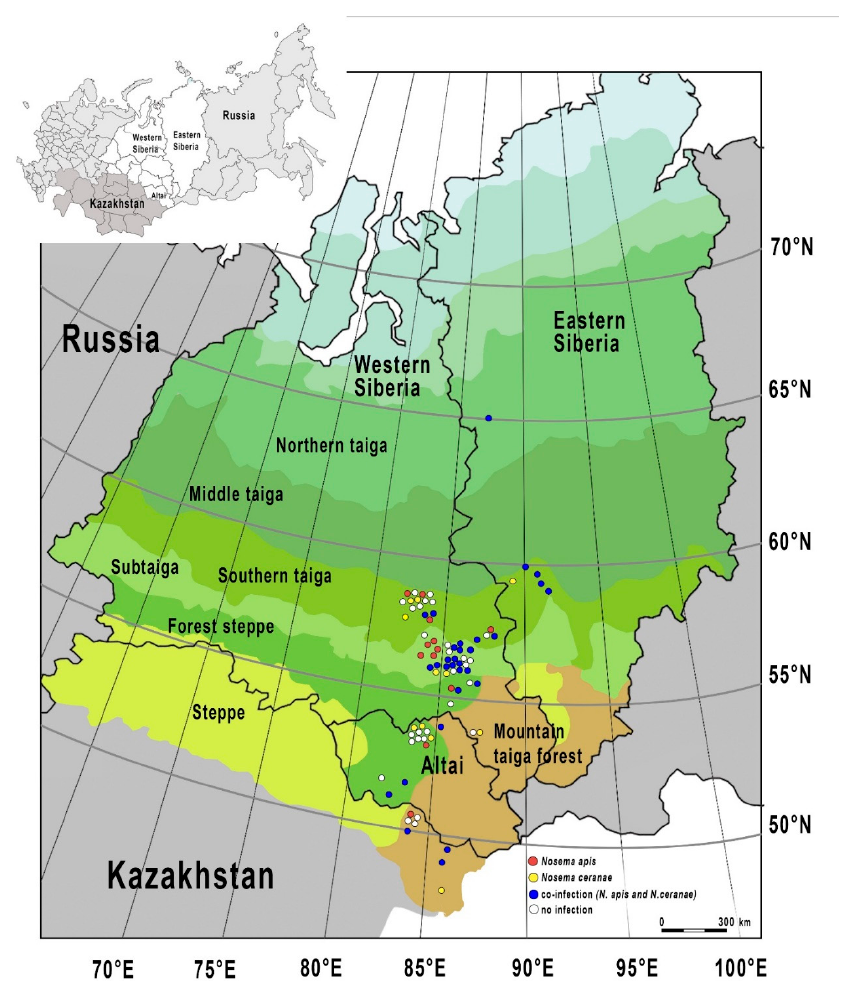
Figure 2. Prevalence of Nosema infections in several ecoregions of North Asia (southern taiga, sub-taiga, forest steppe, and mountain taiga forests).